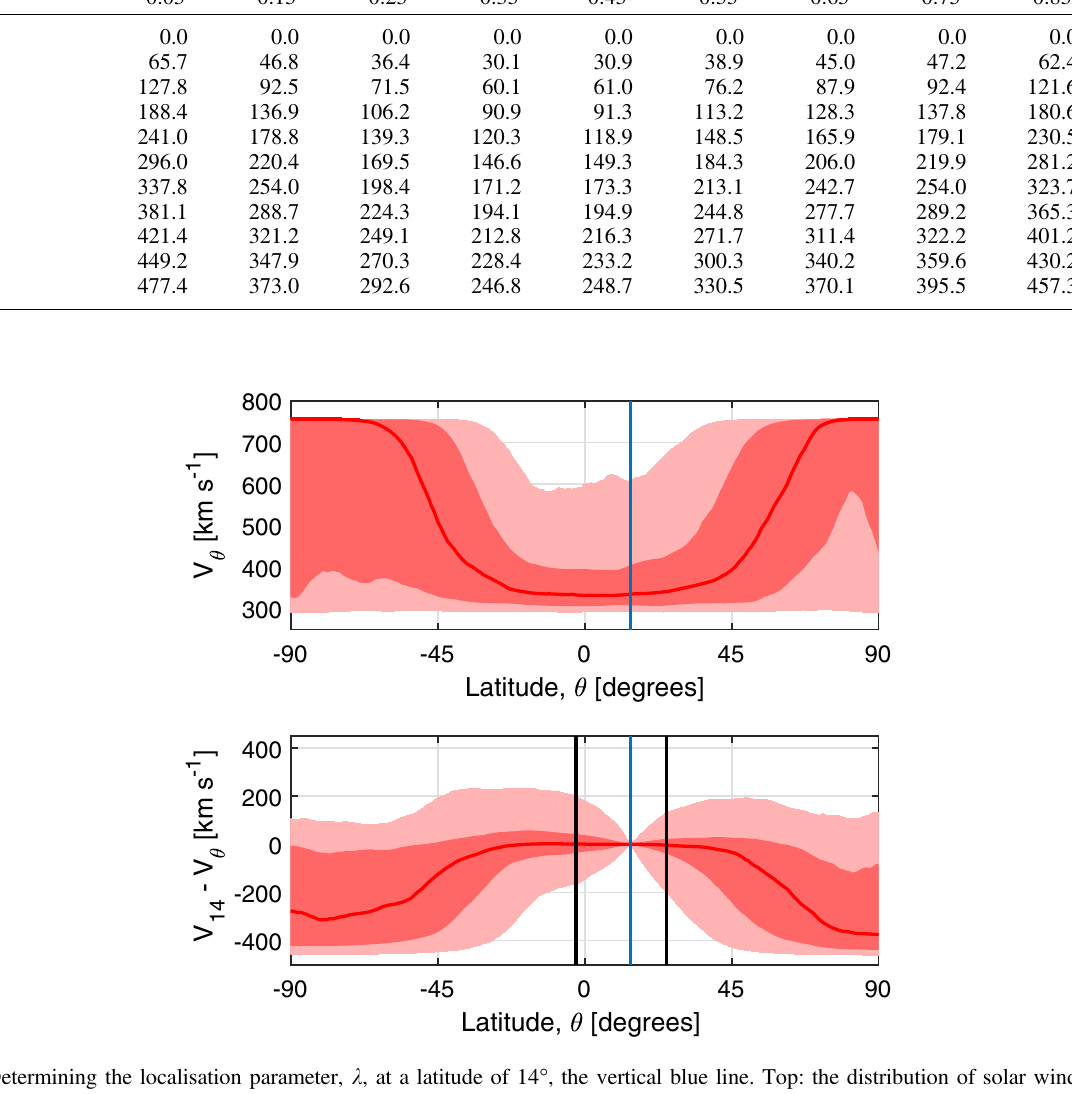
Fig. 7. Determining the localisation parameter, k , at a latitude of 14 (cid:1) , the vertical blue line. Top: the distribution of solar wind speeds as a function of latitude for an interval close to solar maximum (solar cycle phase between 0.4 and 0.5). The red line shows the median, the dark- pink shaded region spans the 25 – 75 percentiles of the distribution (i.e., the inter-quartile range), while the light-pink regions spans 5 – 95 percentiles. Bottom: the distribution of V 14 (cid:3) V h , speed differences between 14 (cid:1) latitude and h . The vertical black lines show the latitudes where either the 5 or 95 percentiles of the V 14 (cid:3) V h distribution fi rst exceed V TOL = 200 km s (cid:3) 1 in magnitude.